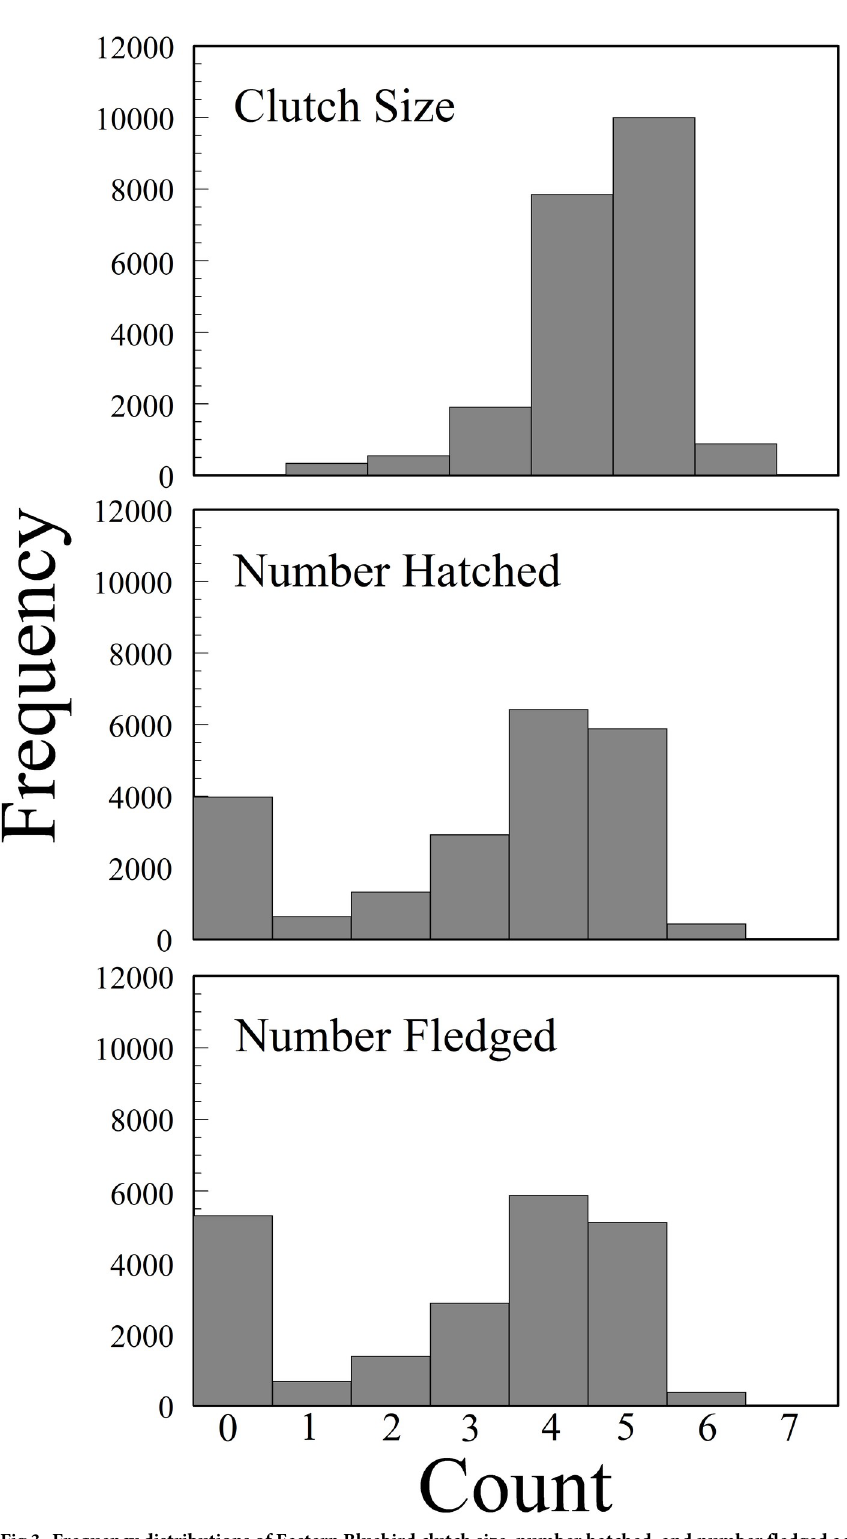
Fig 3. Frequency distributions of Eastern Bluebird clutch size, number hatched, and number fledged across their entire range in North America, 2006–2013.